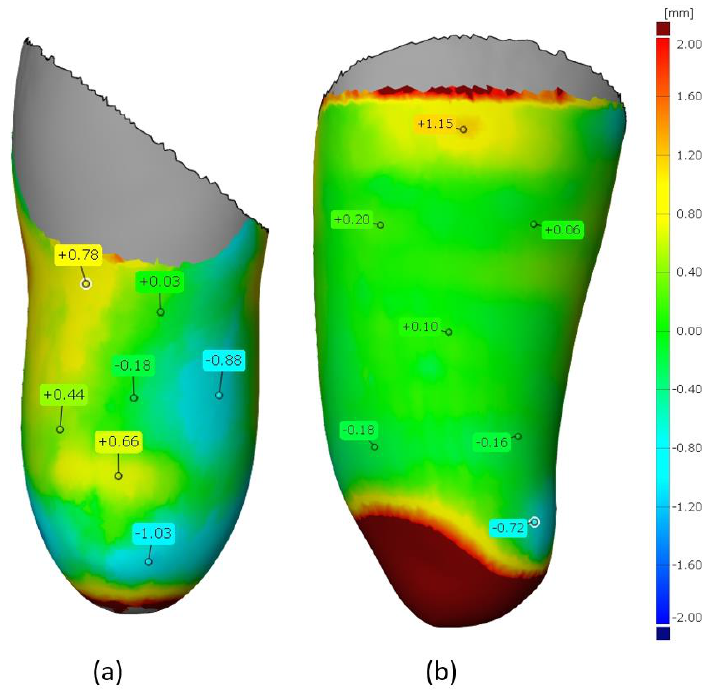
Figure 14. Deviation map for the sockets of TPE. Type: ( a ) VAC and ( b ) VEL.